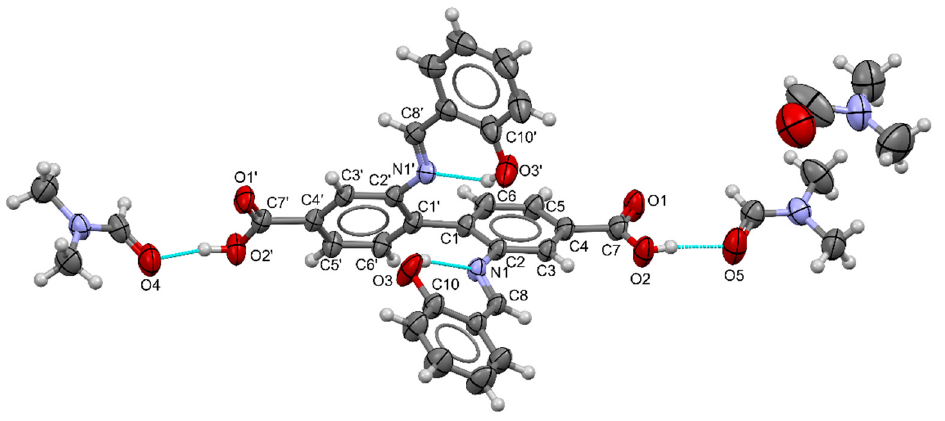
Figure 2. The molecular structure of ligand H 4 L · 3DMF with the numbering of selected atoms. Hydrogen bonds are also shown.